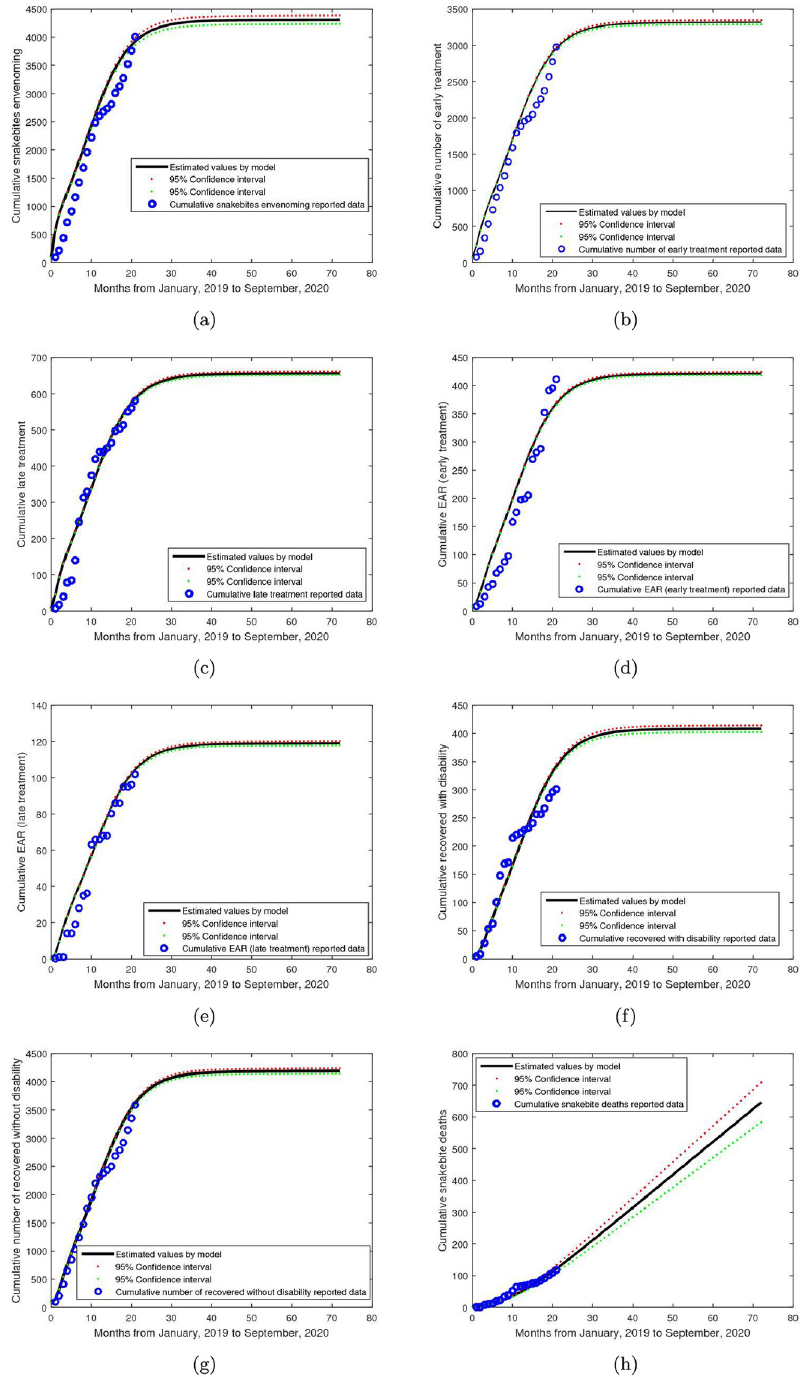
Fig 3. Graphs showing the results of the model fitting with the reported data. The model with constant controls is fitted with the reported cumulative number of (a) snakebite envenoming (b) early treatment (c) late treatment (d) EAR during early treatment (e) EAR during late treatment (f) recovered with disability (g) recovered without disability and (h) snakebite deaths. It can be seen that the model fitted well with the respective data sets collected from the snakebite treatment and research hospital,